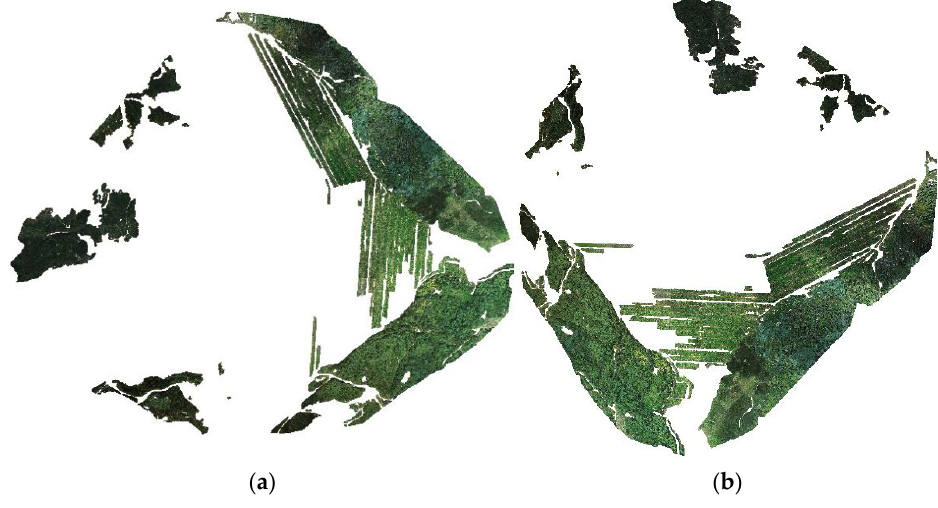
Figure 16. ( a , b ) represent DIM point cloud vegetation